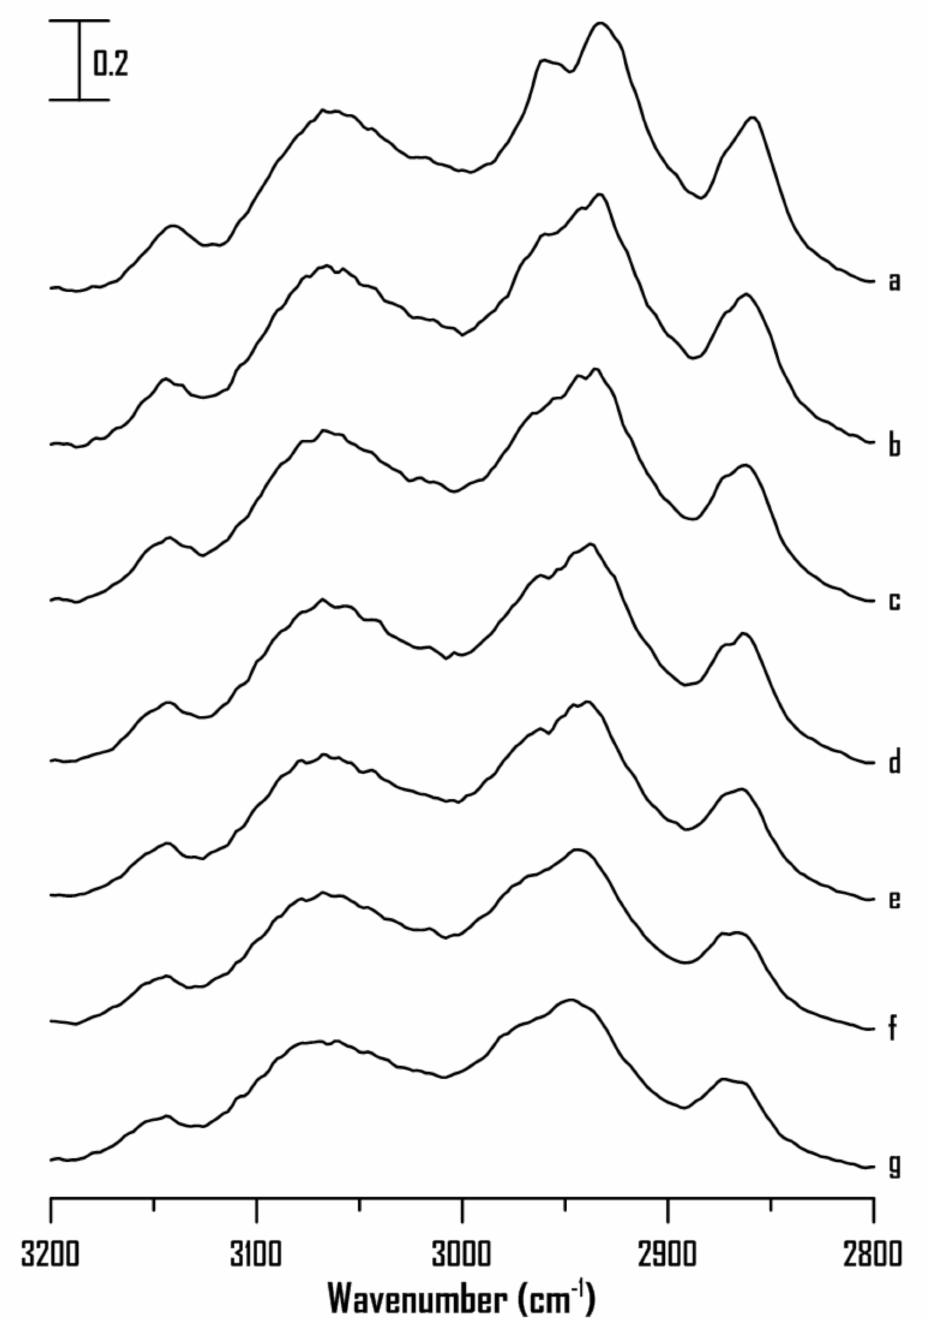
Figure 8. IR spectra of pure [HMIM]Br at ( a ) ambient pressure and ( b ) 0.4, ( c ) 0.7, ( d ) 1.1, ( e ) 1.5, ( f ) 1.8, and ( g ) 2.5